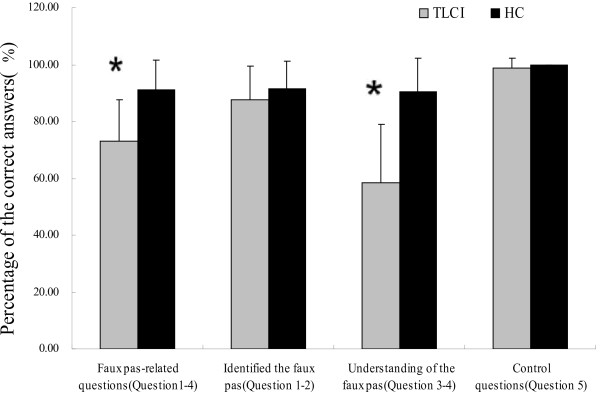
Types of errors made on the faux pas task. The TLCI group had impairment on faux-pas–related questions. The figure indicates that patients with TLCI could correctly identify the faux pas and answer the control questions. The TLCI group made more errors in understanding the mental states of the speakers and listeners than HC (Question 3 and 4) (*p < 0.001 vs. HC).